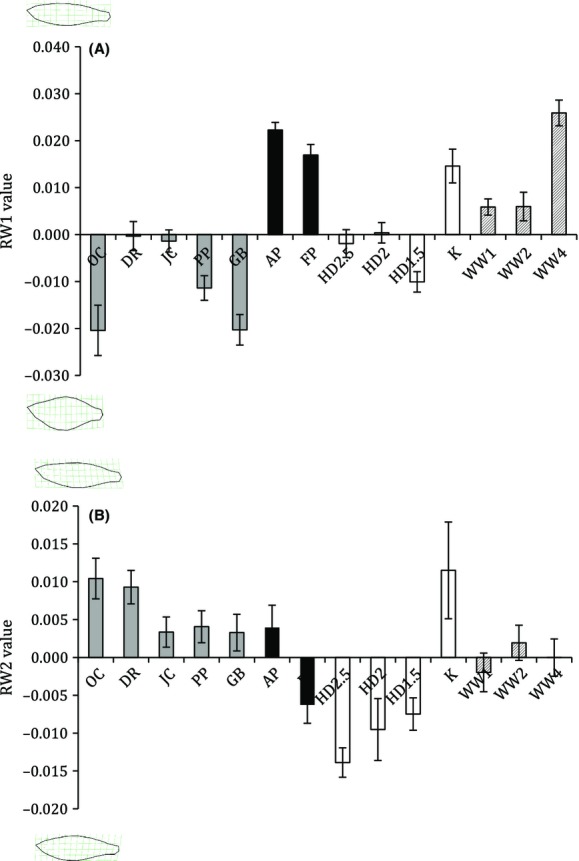
Among-population morphological variation in RW1 (A) and RW2 (B). Images illustrate the extreme morphologies represented by each axis. Shading indicates the subcatchment classification for each population (upper: white, middle: black, lower: gray) with Weeli Wolli Creek (WW) sites (artificially modified flow; hatched) shown separately (see Table 1 for individual site codes).